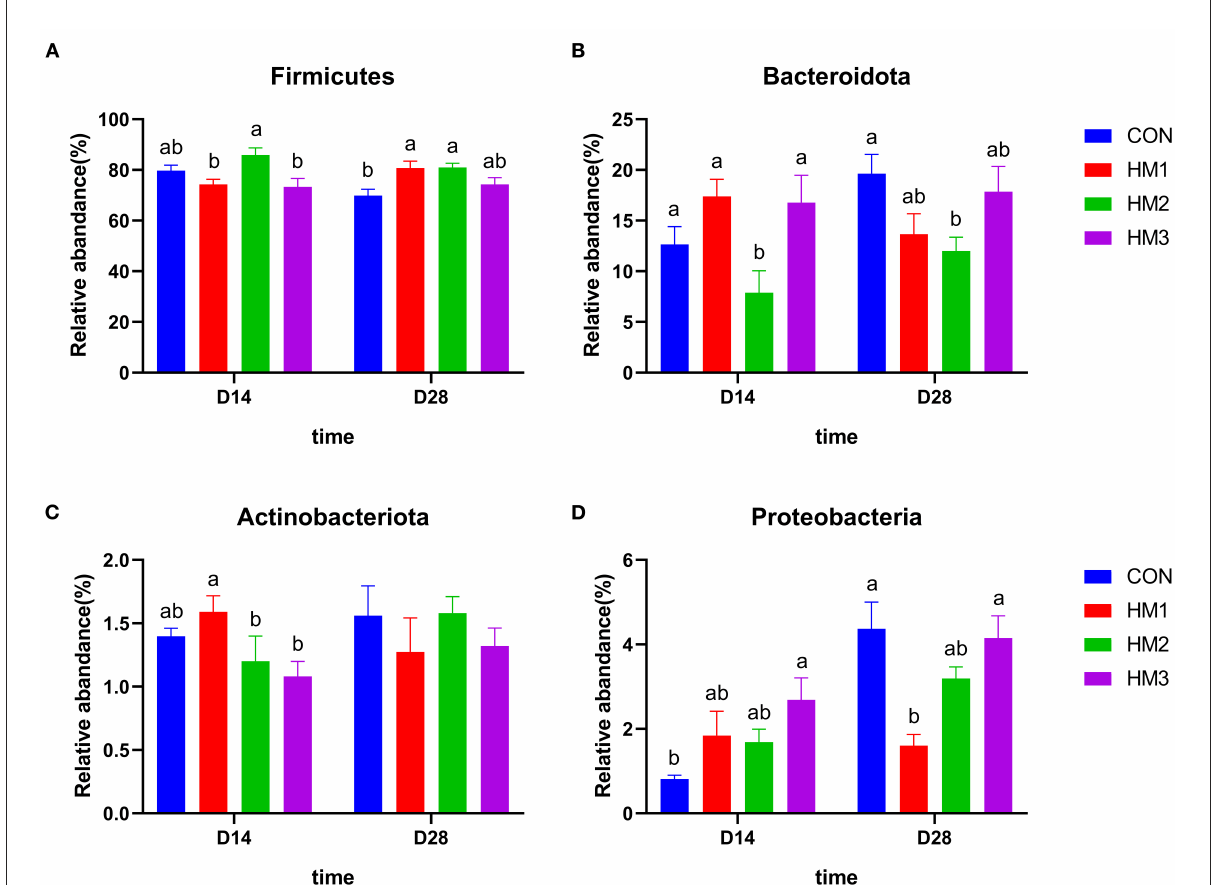
FIGURE3 Comparison of dominant intestinal microbiota at phylum level. Relative abundances of Firmicutes (A) , Bacteroidetes (B) , Actinobacteria (C) , and Proteobacteria (D) among the four groups on d 18 and d 35. CON, basic diet; HM1, basic diet with 0.5 g/kg of herbal mixture; HM2, basic diet with 1.0 g/kg of herbal mixture; HM3, basic diet with 1.5 g/kg of herbal mixture. Different lowercase letters in the figure indicate statistically significant differences ( p <